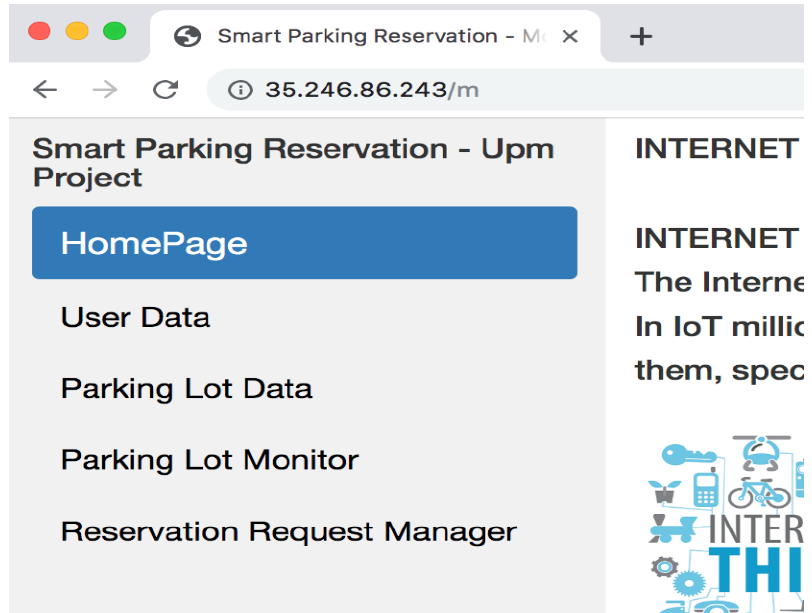
Appl. Sci. 2021 , 11 , x FOR PEER REVIEW Figure 8. Main Visual Interface of the system. Figure 8. Main Visual Interface of the system.